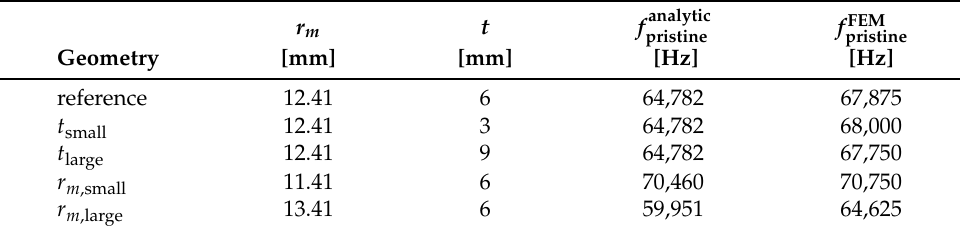
Table 4. Comparison of resonances frequencies of in-plane radial vibration computed analytically with Equation (9) and FEM simulation for different lug